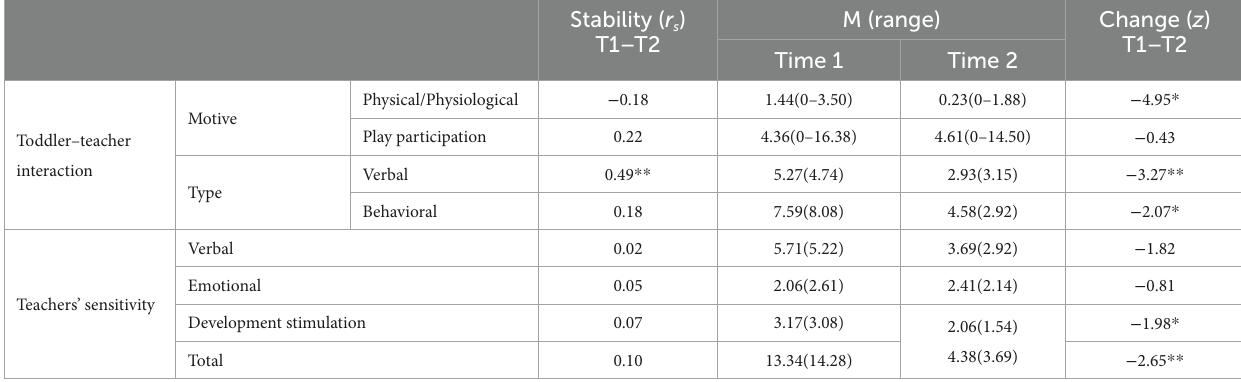
TABLE 5 Stability and changes on study variables over